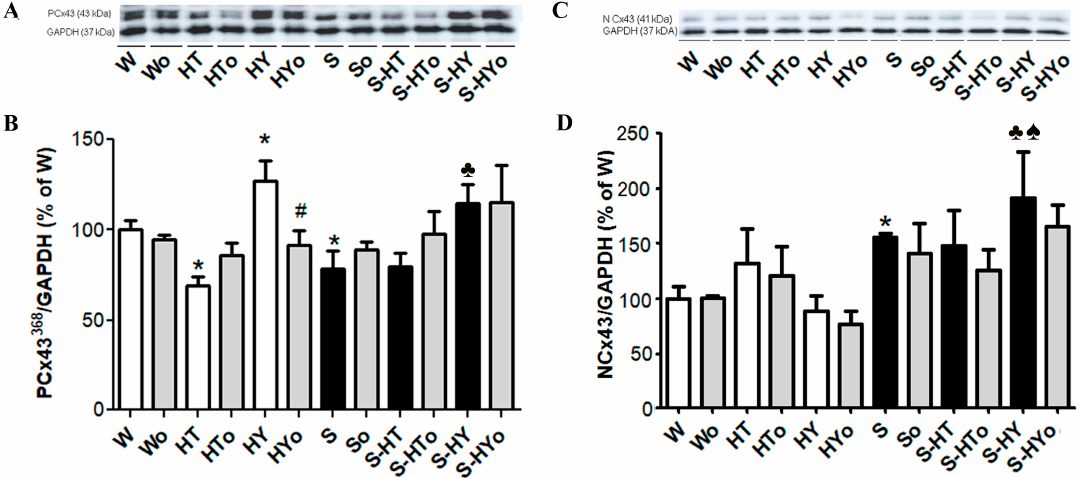
Figure 2. Myocardial protein abundance of the phosphorylated form of connexin-43 (Cx43) specifically on Serine368 ( A and B ) and non-phosphorylated form of Cx43 ( C and D ) normalized to glyceraldehyde-3-phosphate dehydrogenase (GAPDH) protein level in the male normotensive and hypertensive rats with altered thyroid status with or without feeding with Omacor. W—Wistar Kyoto euthyroid control rats; o—fed with Omacor; HT—hyperthyroid rats; HY—hypothyroid rats; S—spontaneously hypertensive rats; n = 6 in each group. Data are presented as means ± SD; * p < 0.05 vs. W; ♣ p < 0.05 vs. S; # p < 0.05 untreated vs. treated with Omacor; ♠ p < 0.05 HT vs. S-HT/ HY vs. S-HY.